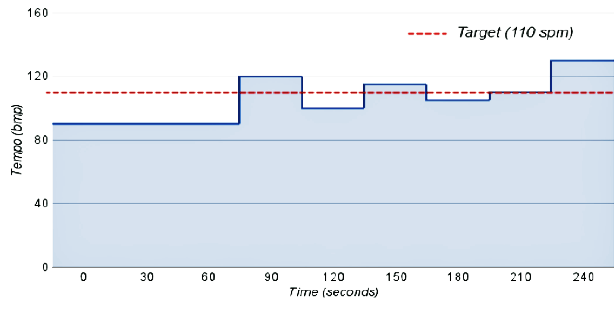
Figure 2 : Tempo pattern of test track